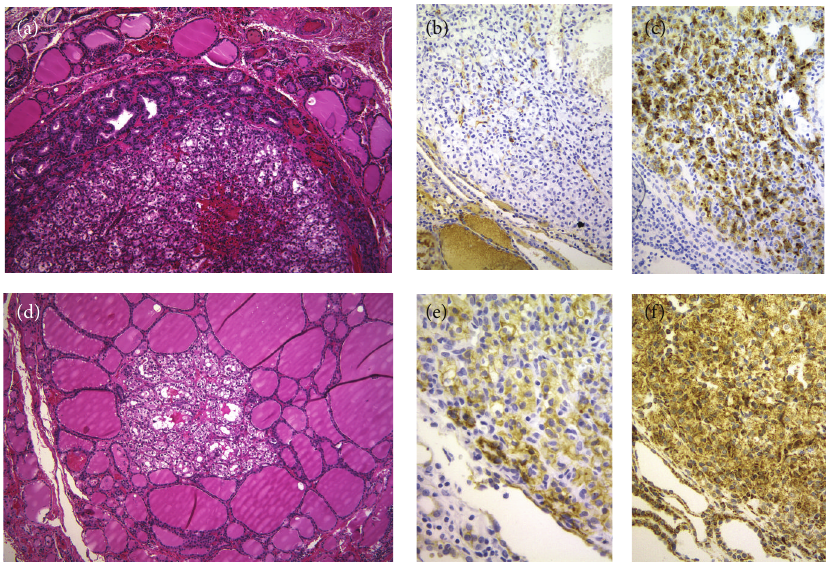
Figure 3: Tumor-in-tumor. (a and d) Two foci of metastatic renal cell carcinoma presented as central lesions inside hyperplastic adenomatoid nodules (hematoxylin and eosin). Tumor cells of renal cell carcinoma were negative for thyroglobulin (b) but positive for CD10 (c), EGFR (e), and VEGFR2